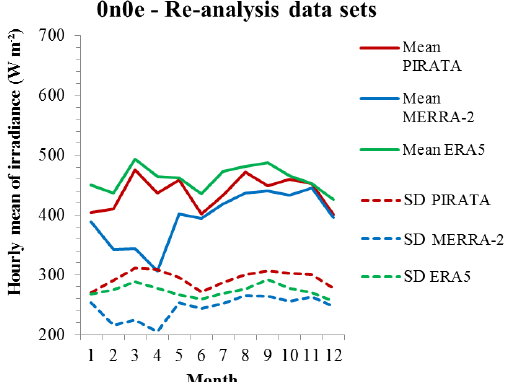
Figure A6. Monthly means (solid lines) and standard deviations (dotted lines) of hourly DSIS, in Wm − 2 , from PIRATA measurements (red) and data sets (MERRA-2: blue, ERA5: green) at 0 ◦ N, 0 ◦ E. A difference between red line (measurements) and coloured line (data set) for a given month denotes a systematic error for this month: underestimation if the coloured line is below the red line, overestimation otherwise. For a given month, a coloured dotted line above the red one means that the data set produces too much variability for this month; in the opposite case, the data set does not contain enough